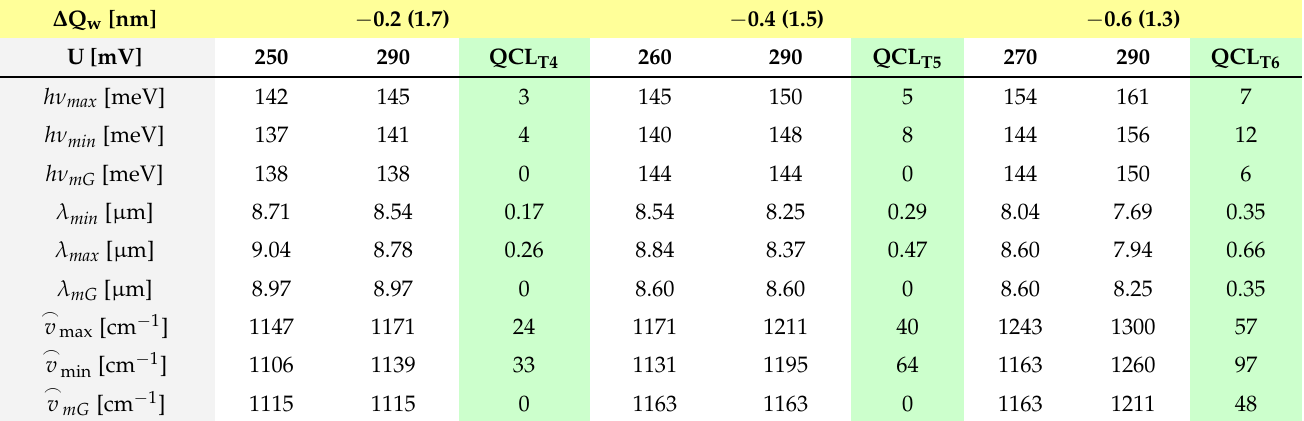
Table 4. Modeling the QCL tuning range by narrowing the size of the Q w well width. ∆ Q w